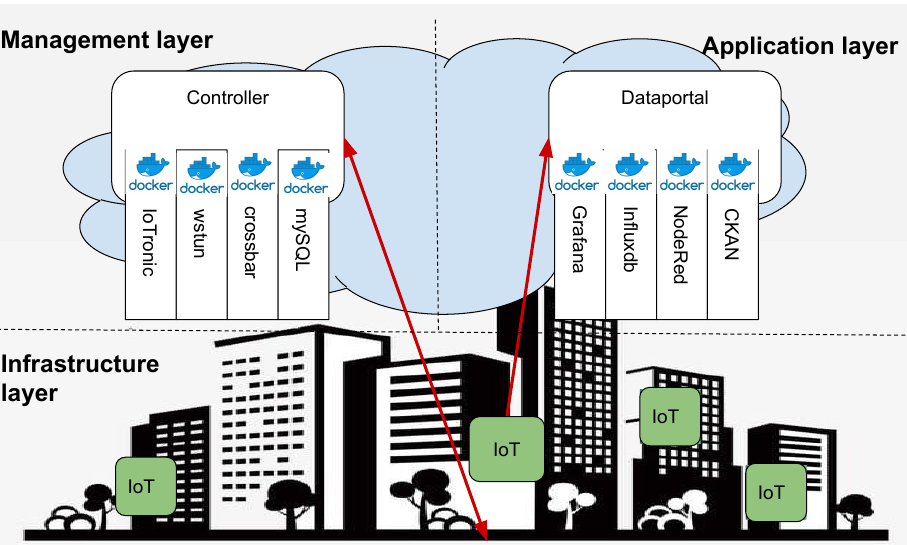
Figure 11. Easy to replicate architectural template of a smart city released in an Italian project called